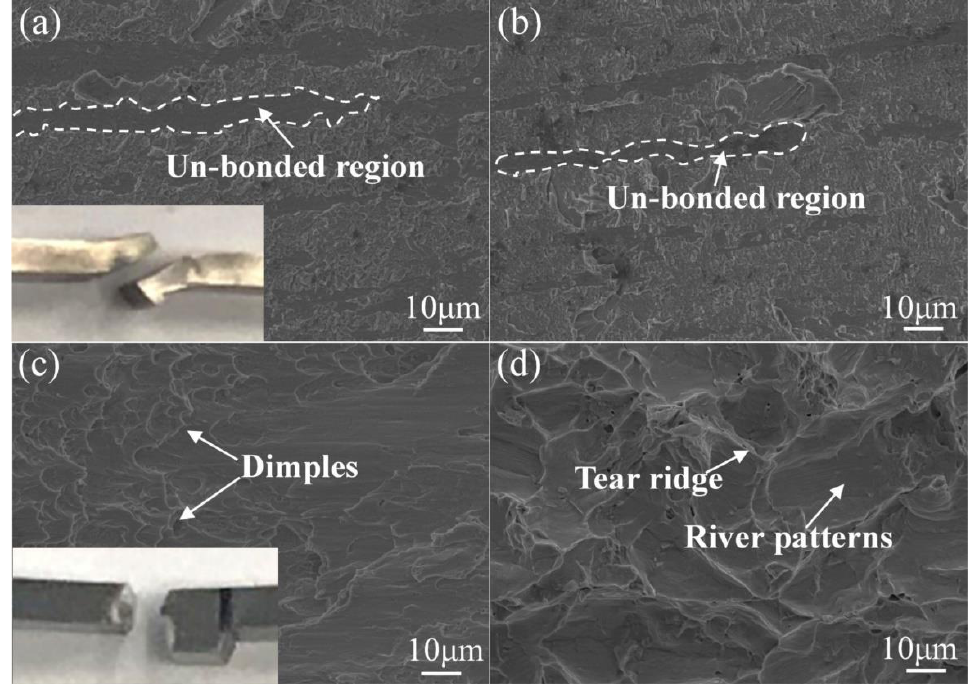
Figure 8. Fracture morphologies of the joint bonded at different temperatures (7 MPa/60 min): ( a , b ) 760 °C, ( c ) 800 °C, and ( d ) 820 °C, and insert pictures are the physical pictures of the broken joints.